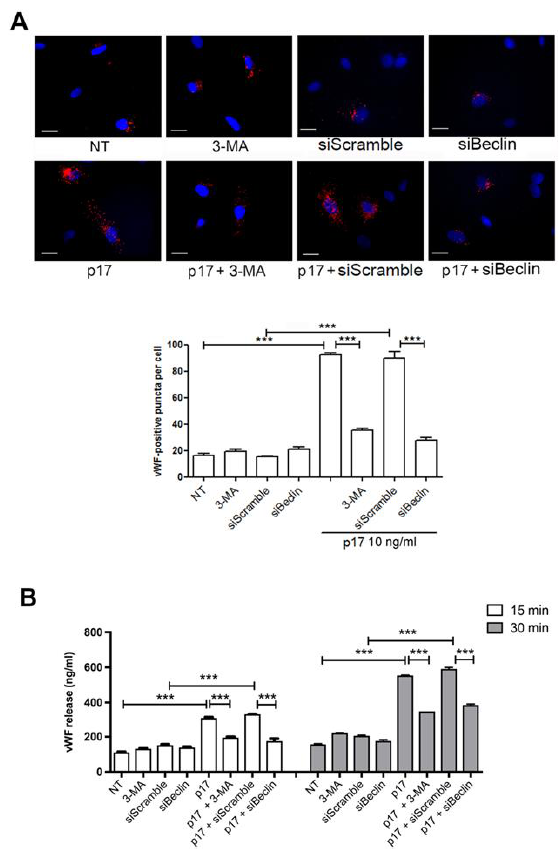
Figure 4. Inhibition of autophagy decreases p17-mediated release of vWF in HMVEC-Ls. ( A ) HMVEC-Ls were nucleofected with a mCherry-vWF plasmid and, when indicated, in combination with siBeclin-1 or irrelevant (siScramble) siRNAs. Twenty-four h after nucleofection, cells were serum starved for 16 h and then stimulated or not with 10 ng/mL of p17 in complete medium. When indicated, HMVEC-Ls were serum starved for 16 h in the presence or absence of 3-MA (5 mM). The images display vWF signals in red and cell nuclei in blue. Scale bar, 10 μm. Red-positive punctate structures were counted in order to quantify the levels of WPBs. NT indicates not treated cells. Values reported for vWF positive structures are the mean ± SD of 3 independent experiments with similar results. Statistical analysis was performed by one-way ANOVA, and the Bonferroni post-test was used to compare data (*** p < 0.001). ( B ) HMVEC-Ls were serum starved for 16 h in the presence or absence of 3-MA (5 mM). When indicated, cells were nucleofected with siBeclin-1 or irrelevant (siScramble) siRNAs and 24 h after nucleofection were serum starved. After serum starvation, cells were cultured in complete medium containing or not 10 ng/mL of p17. Supernatants were collected at 15 and 30 min of culture and analyzed for the presence of vWF by a standard quantitative ELISA. Bars represent the mean ± SD of triplicate samples. Statistical analysis was performed by one-way ANOVA, and Bonferroni post-test was used to compare data (*** p < 0.001). NT indicates not treated cells.